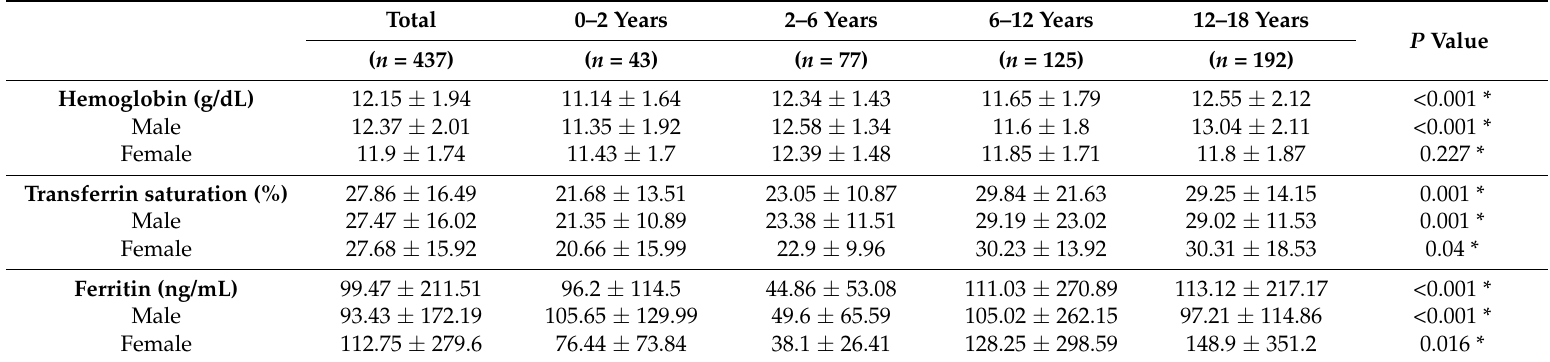
CKD, chronic kidney disease; n , number of patients; * Statistical significance was demonstrated using the Kruskal–Wallis test. Table 4. Hemoglobin, transferrin saturation, and ferritin levels stratified by CKD stage. Numerical values are reported as n (%); CKD, chronic kidney disease; n, number of patients. * More detailed data are described in supplementary Table S1; ※ CKD stage III is divided into subgroup stage IIIa and IIIb according to the eGFR (estimated glomerular filtration rate), stage IIIa is an eGFR between 45 and 59 and Stage 3b is an eGFR between 30 and 44; † Disease duration refers to the years between the date of the baseline data collection and the CKD diagnosis date; ‡ Duration of aggravated renal function means the years between the date of the baseline data collection and the date of onset of the preceding disease to CKD.